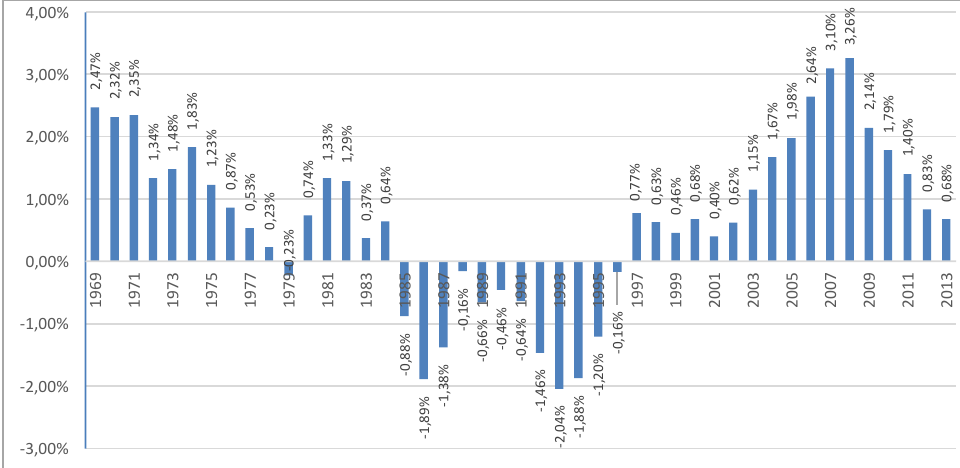
Figure 6 5 Year moving average growth of per capita GDP at constant 2005